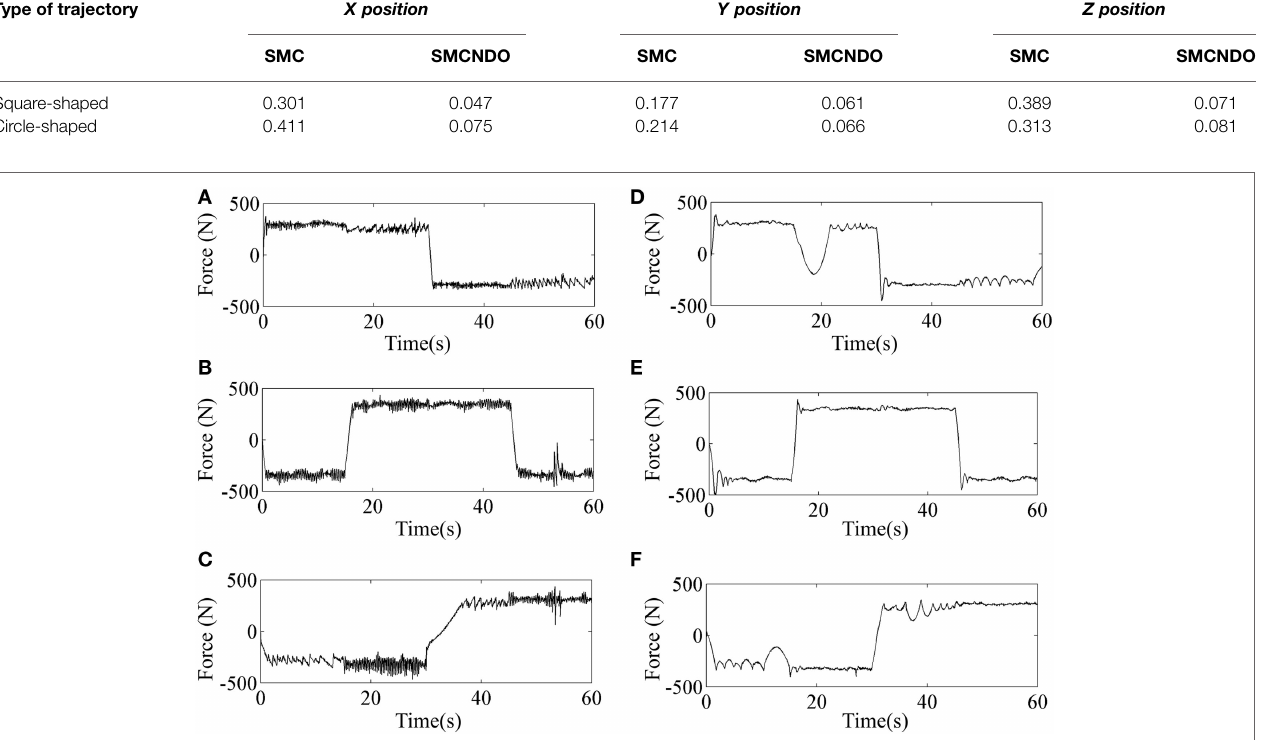
TABLE 2 | Root mean square errors (cm) in the three coordinate directions by implementation of sliding mode control (SMC) and sliding mode control with nonlinear disturbance observer (SMCNDO) when a healthy subject follows a square-shaped and a circle-shaped trajectory. Type of trajectory X position